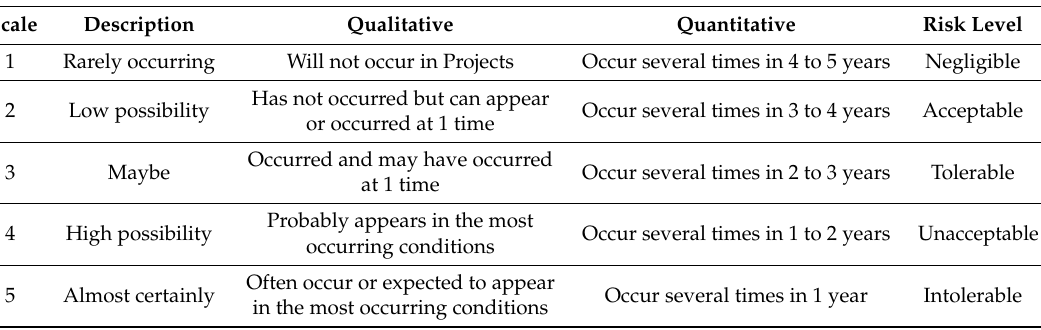
Table 2. Frequency level